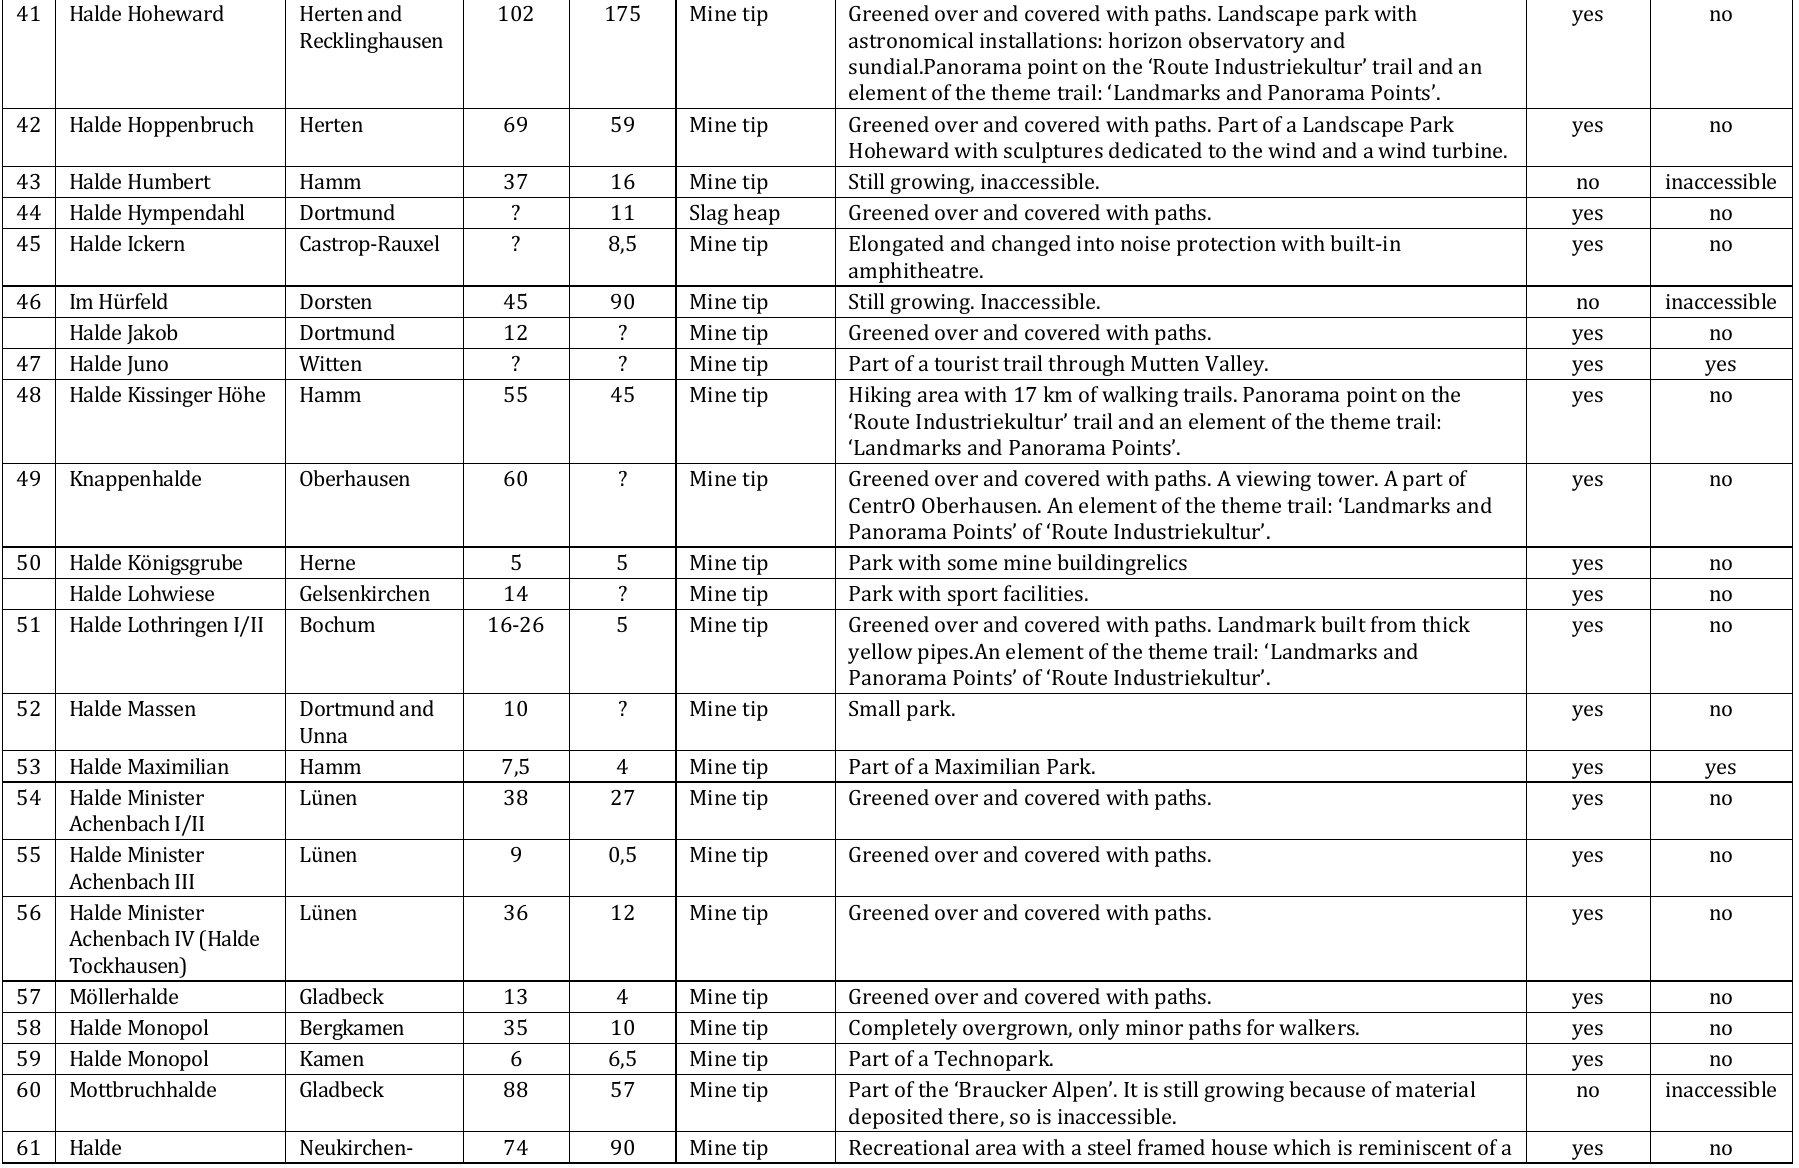
Greened over and covered with